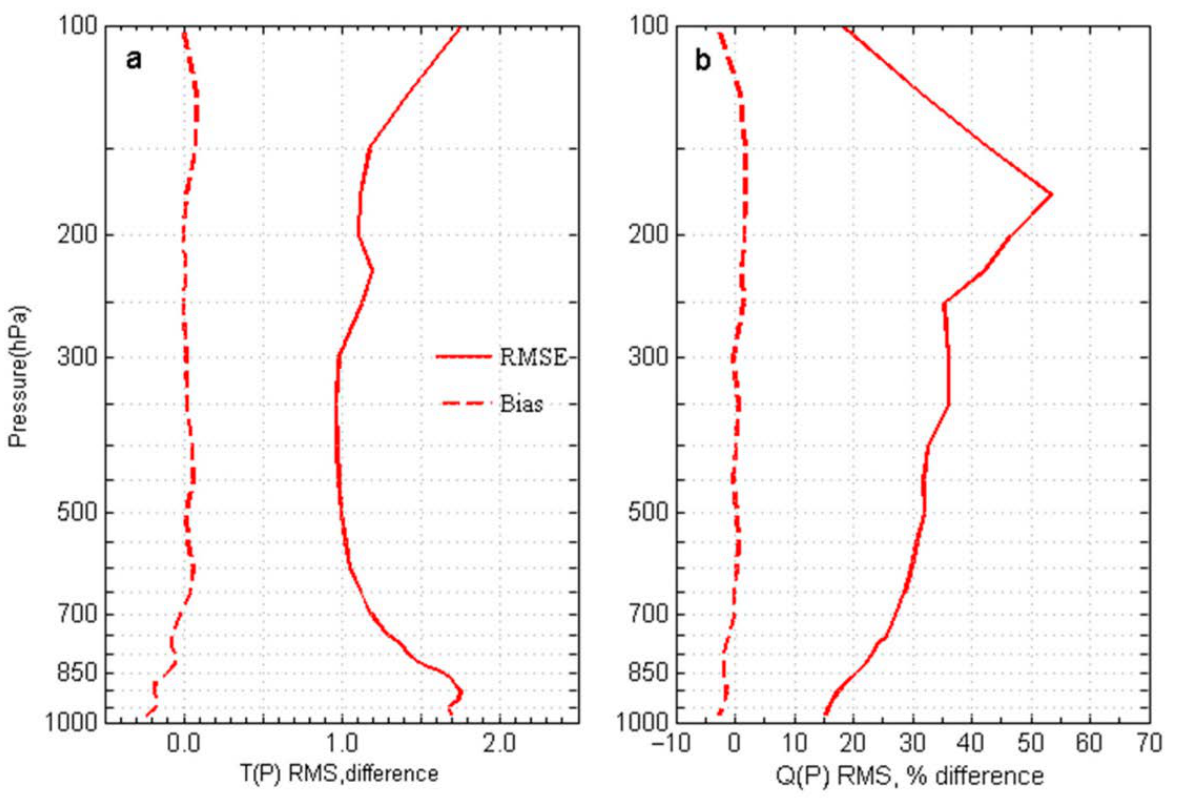
Figure 10. The RMSE and bias of temperature ( a ) and relative humidity ( b ) profiles between the retrieval results and ERA5 data.